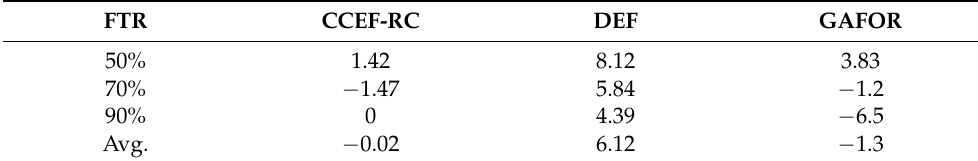
Table 5. Energy efficiency.